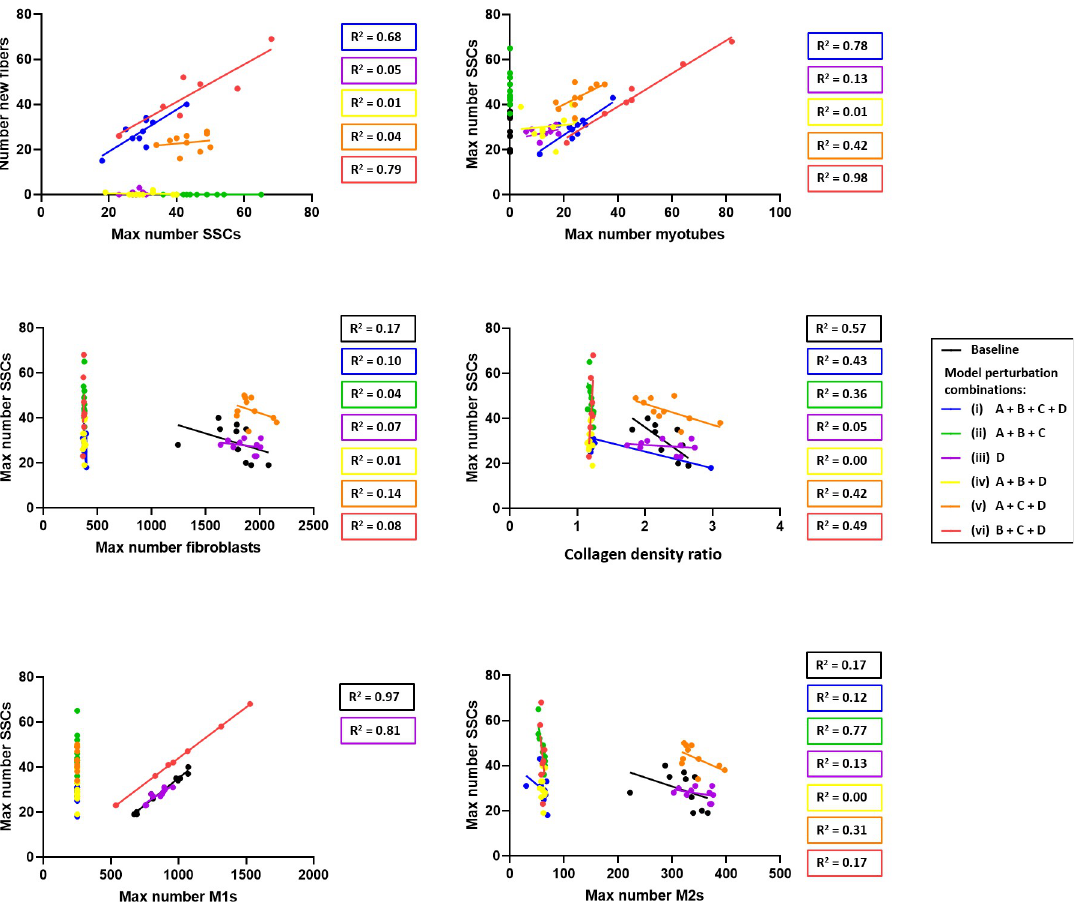
Fig 10. In model perturbation combinations i and vi, the number of new fibers correlated with the maximum number of SSCs. In model combinations i, v, and vi, the maximum number of SSCs correlated with the maximum number of myotubes. In perturbation “A”, the maximum number of M1 macrophages and in perturbation “B”, the maximum number of fibroblasts were reduced to 75% of baseline levels. In perturbation “C”, SSC migration behaviors were adjusted such that SSCs preferred being in isolation on ECM as opposed to in their niche next to a fiber. Model perturbation D, which corresponded to the threshold for SSC differentiation into myofiber, was reduced so that SSC differentiation was more frequent. R 2 values quantify the goodness of fit for linear regression. If R 2 values are not shown, then the linear regression was a perfect line (R 2 = 1). ROUT analysis was used to identify outliers for each model combination and three outliers were identified in combination